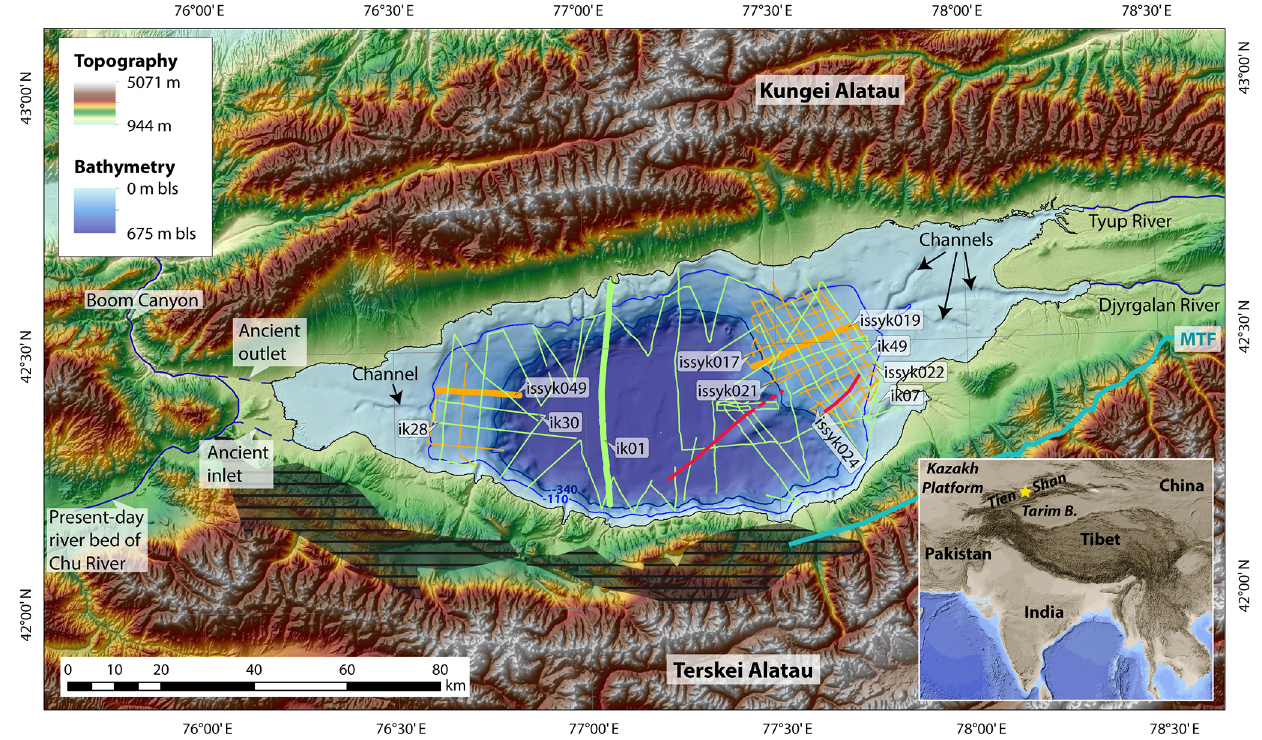
Figure 1. Geographical setting of Lake Issyk-Kul. Track lines of all profiles used in this study are shown in green (data from 1997) and orange (2001). Profiles shown in Figs. 3–6 and 8 are shown by bold lines. The axes of two anticline structures visible in the seismic profiles in the southeastern part of the lake are marked in red. Grey hatched areas mark the approximate position of the Issyk-Kul broken foreland. Blue line shows the approximate location of the main Terskey Fault (MTF; after Macaulay et al., 2014). Digital terrain model for the lake and surroundings from Delvaux et al. (2001). Bathymetry is given in meters below lake surface (mbls). Inset shows the location of our study site marked by a yellow star (map generated using the ETOPO1 dataset, Amante and Eakins (2009), projection: WGS84 UTM Zone 43N).